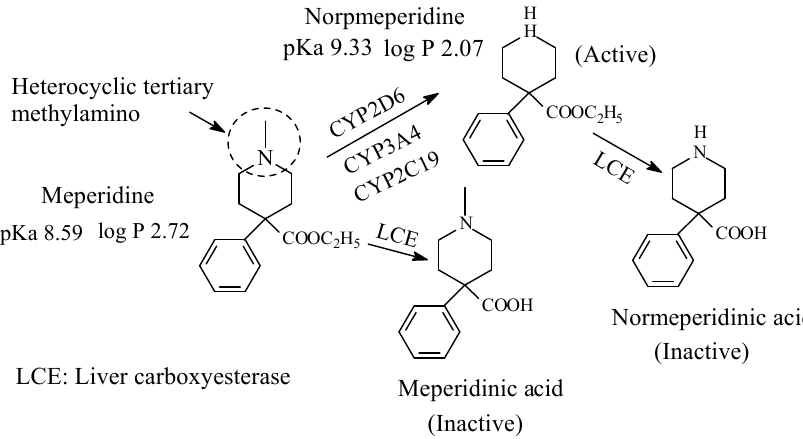
Figure 28. Metabolic pathways of meperidine (pethidine).